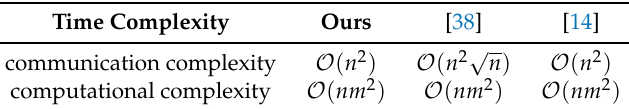
Table 5. Time complexity comparison.